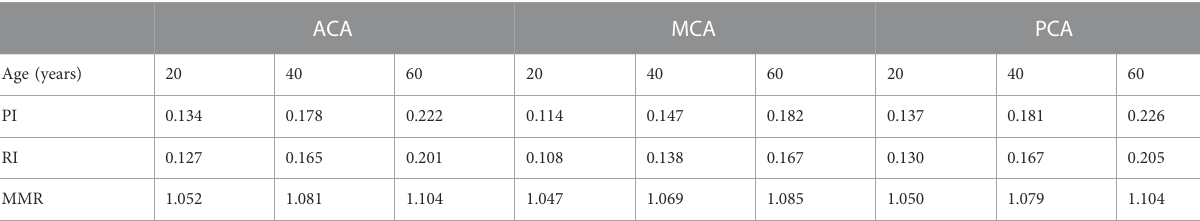
TABLE 2 Simulated PPG waveform features in normal intracranial capacitance.